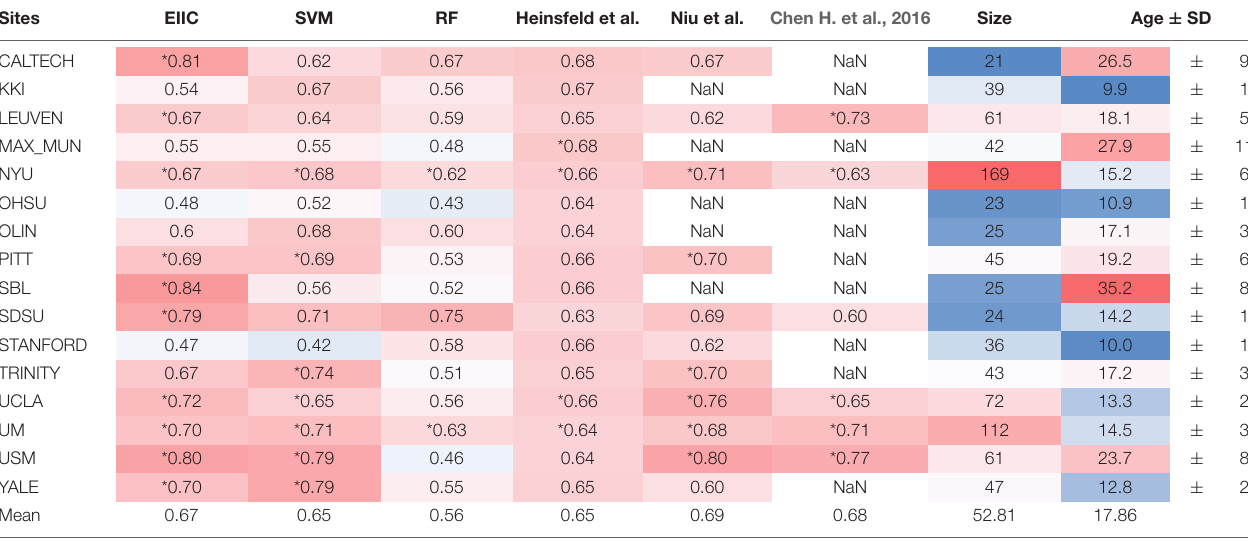
We adjusted the background color based on cell value. The result of each classifier (column) is depicted darker in red if an accuracy rate > 0.5 approaches 1 (the perfect value). In contrast, values < 0.5 acquired a darker background shade of blue by approaching 0 (the complete misclassification). The dataset size and the mean participants’ age are also emphasized by a similar gradual color scale between darkest red (maximum value) and darkest blue (minimum value). *p < 0.01, binomial test, chance level set at 50%. LOSO-CV, leave-one-site-out